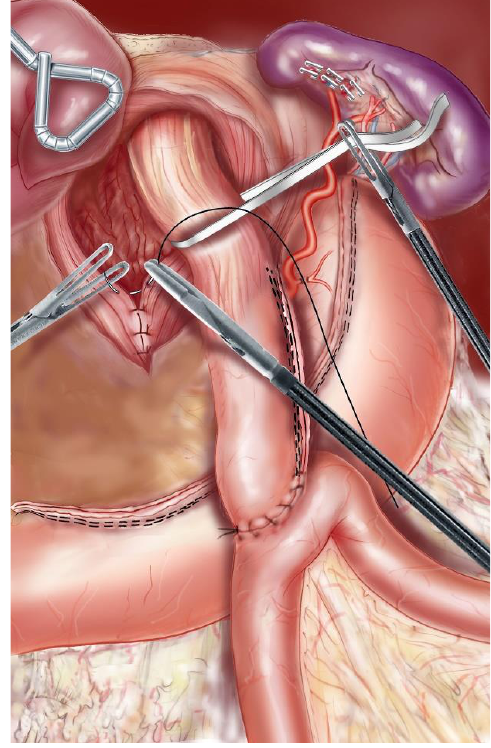
Figure 2. The hiatus was closed with 2 – 3 separate stitches of nonabsorbable sutures.